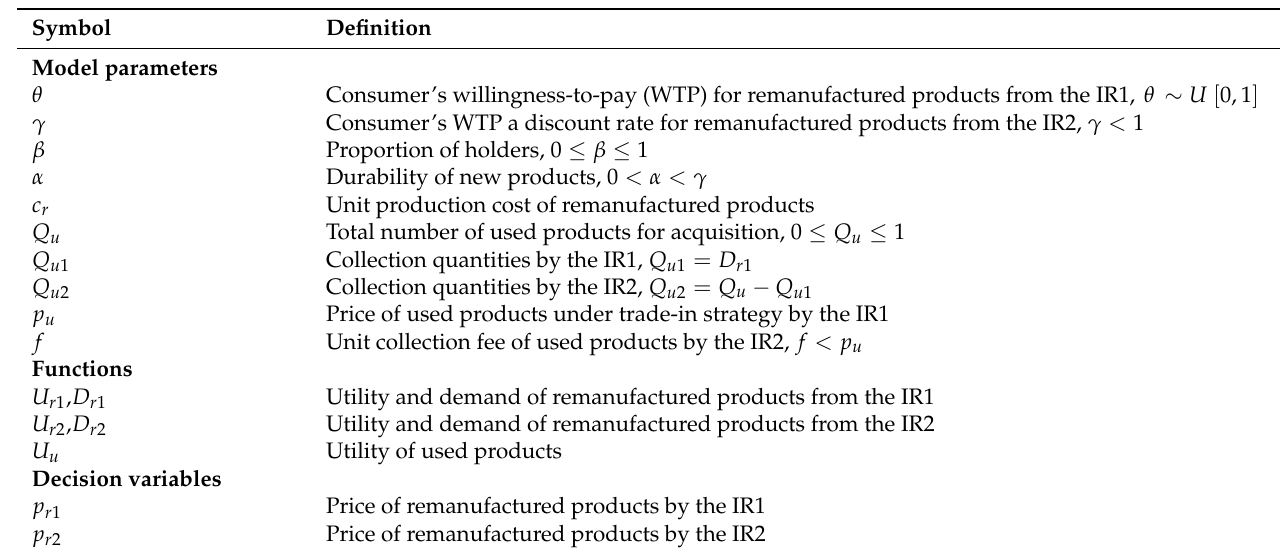
Table 2. The parameters and variables used in our model.